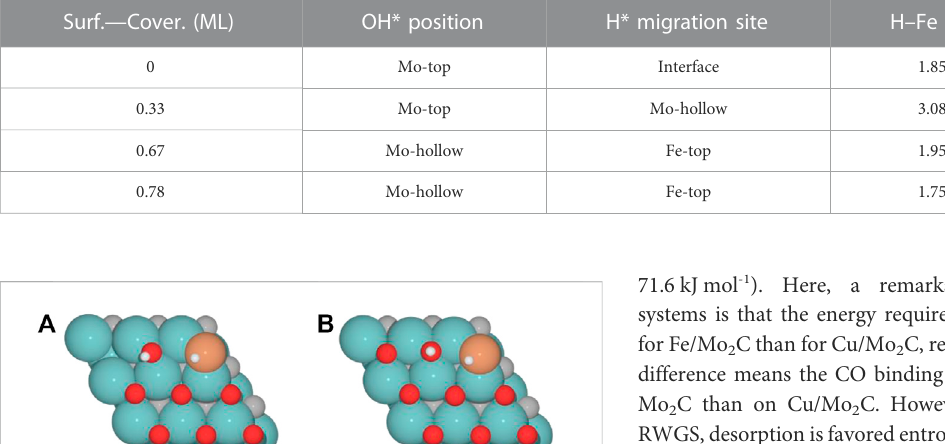
TABLE 2 Summary of OH* position, H* migration ’ s site, and H – Fe and H – OH bond lengths for the H* atom migration step from the Fe/Mo 2 C interface to OH* involved in the H 2 O* formation step (TS3) of the RWGS catalyzed by the Fe/Mo 2 C system in Å. Surf. — Cover. (ML)